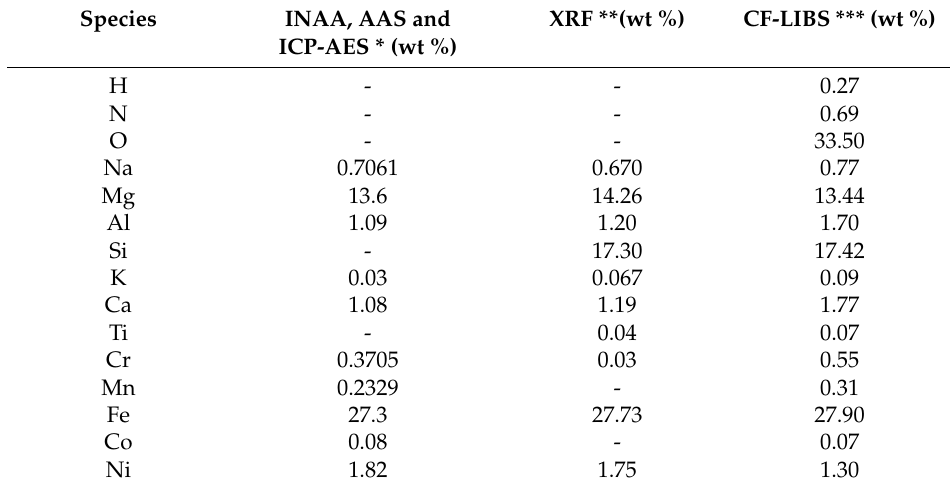
Table 3. Element concentrations in wt % in the Dergaon meteorite from di ff erent measurements. Species INAA, AAS and XRF **(wt %) CF-LIBS *** (wt %) ICP-AES * (wt %) H - - 0.27 N - -